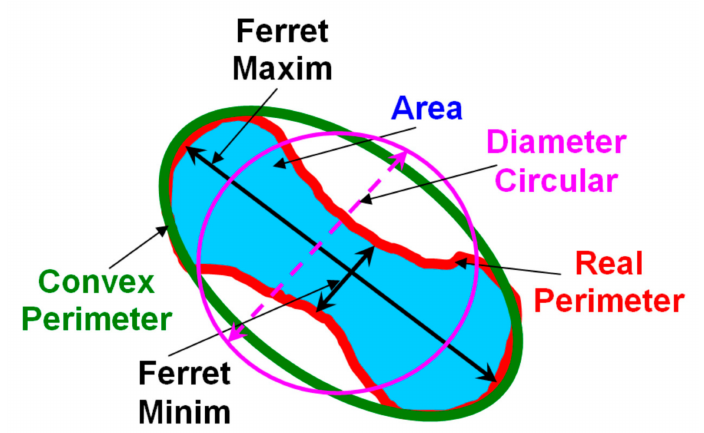
Figure 8. Considered Graphite Particle Parameters in image